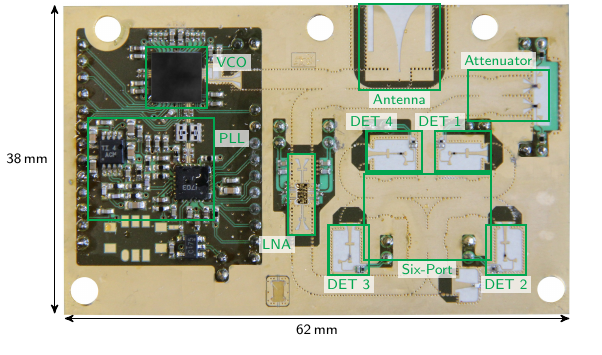
Figure 9. Photo and schematic of a 61-GHz six-port radar front-end realized in substrate-integrated-waveguide (SIW) technology.